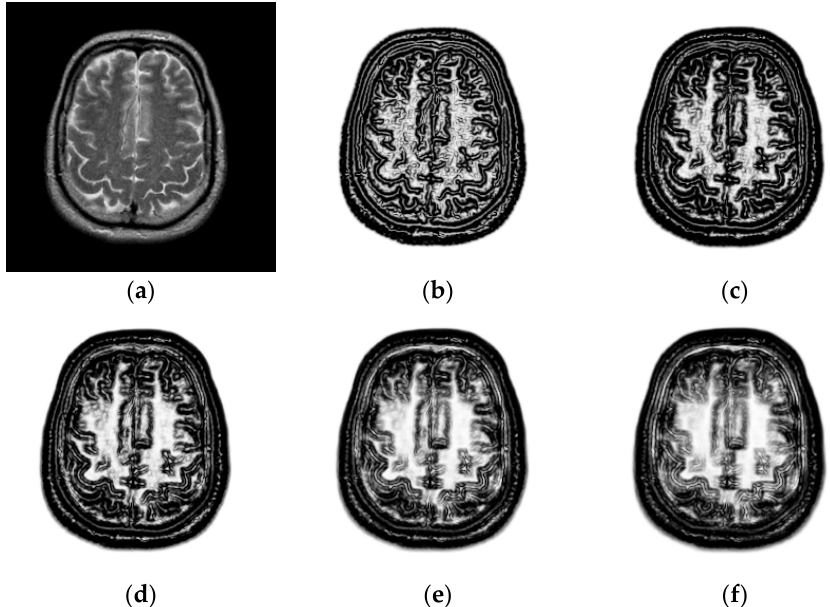
Figure 4. PSR with the different patch sizes. ( a ) T2-weighted magnetic resonance (MR) images in the Atlas dataset; ( b ) patch size: k 1 = k 2 = 3; ( c ) patch size: k 1 = k 2 = 5; ( d ) patch size: k 1 = k 2 = 7; ( e ) patch size: k 1 = k 2 = 9; ( f ) patch size: k 1 = k 2 = 11.